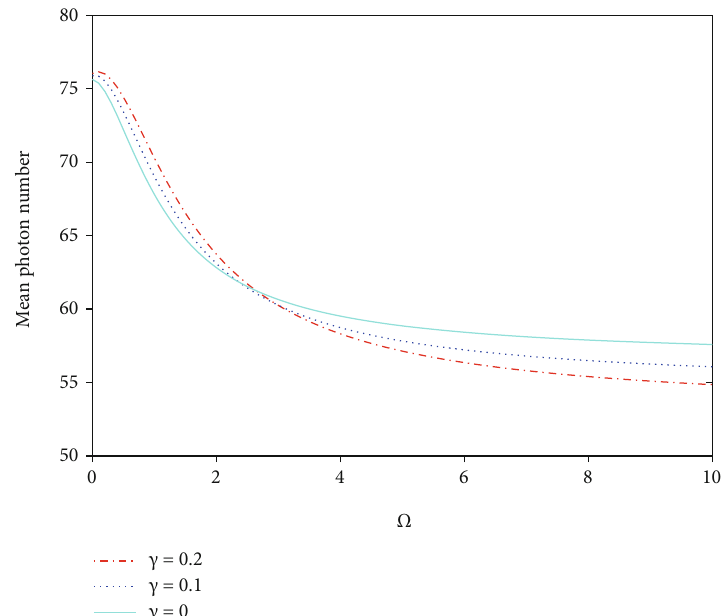
Figure 4: Plots of the steady-state mean photon number versus Ω for γ